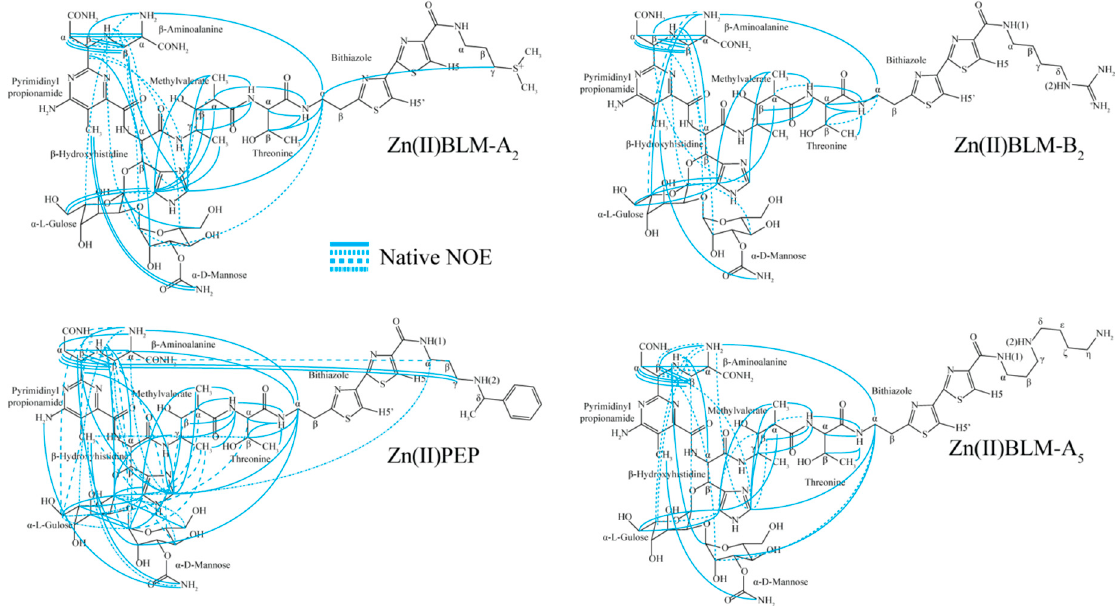
Figure 4. Inter-residue intramolecular NOEs for each Zn(II)BLM under study in their native forms. Data taken from spectra acquired in H 2 O at 5 °C for Zn 2+ :BLM samples in a 1:1 molar ratio. Dashed and continuous lines all represent NOE connectivities, they are used to avoid confusion in busy sectors of the figure.